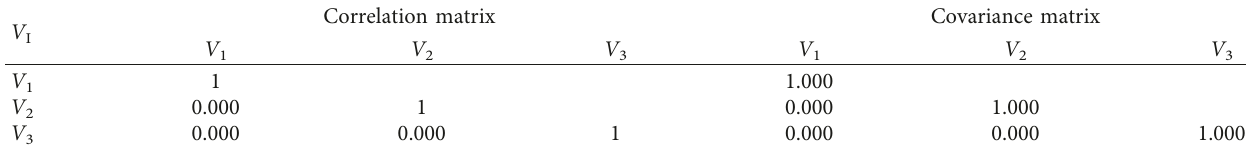
Table 10: Variable group score correlation and covariance